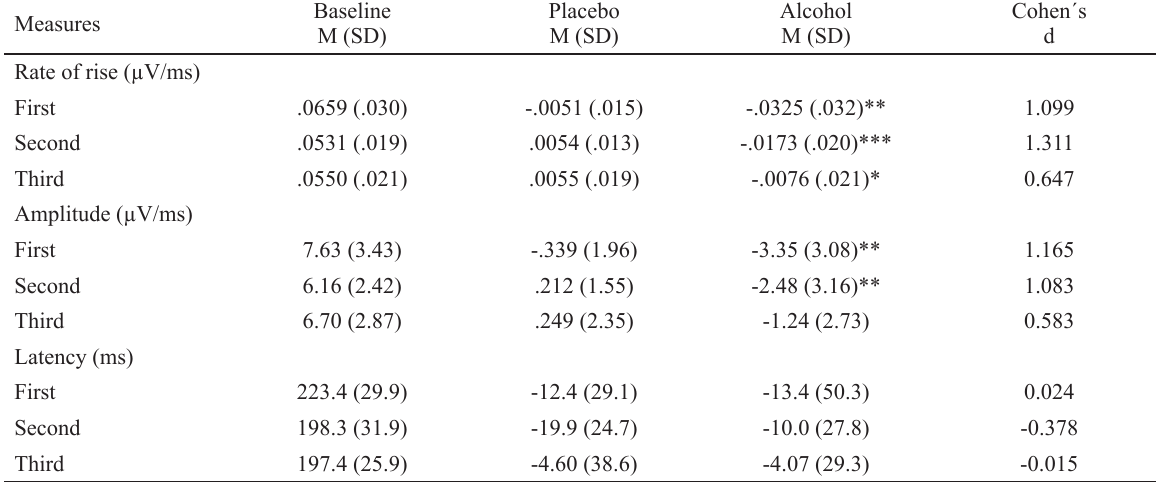
Mean (SD) measures of the P2 component of the auditory evoked potentials on the drug-free baseline test ( N = 30), and the mean (SD) change in this measures in placebo or alcohol treatment groups ( n = 15), according to their ordinal